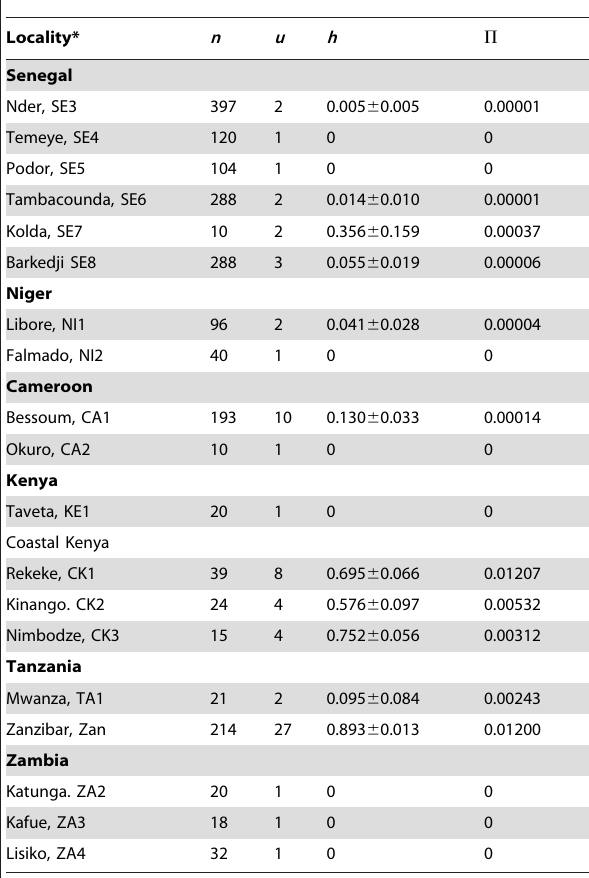
Table 2. Within locality cox 1